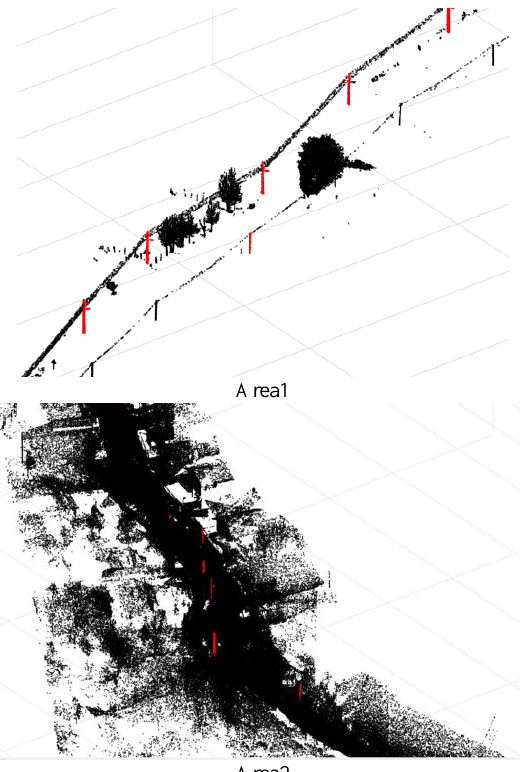
Figure 6. Final results of light poles